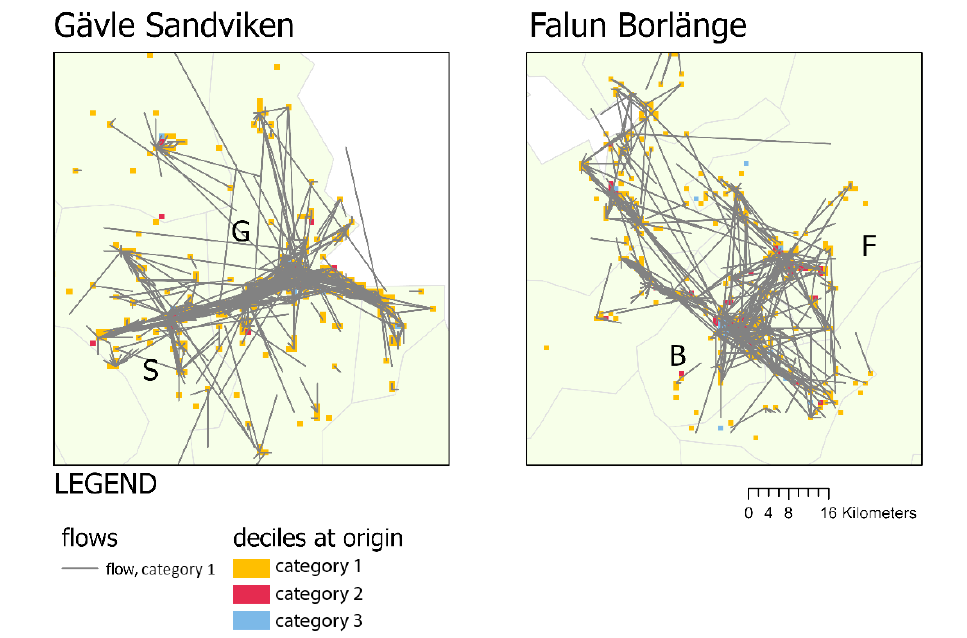
Figure 4. Flows starting in category 1. Note: Data from 28 March 2019, Thursday.